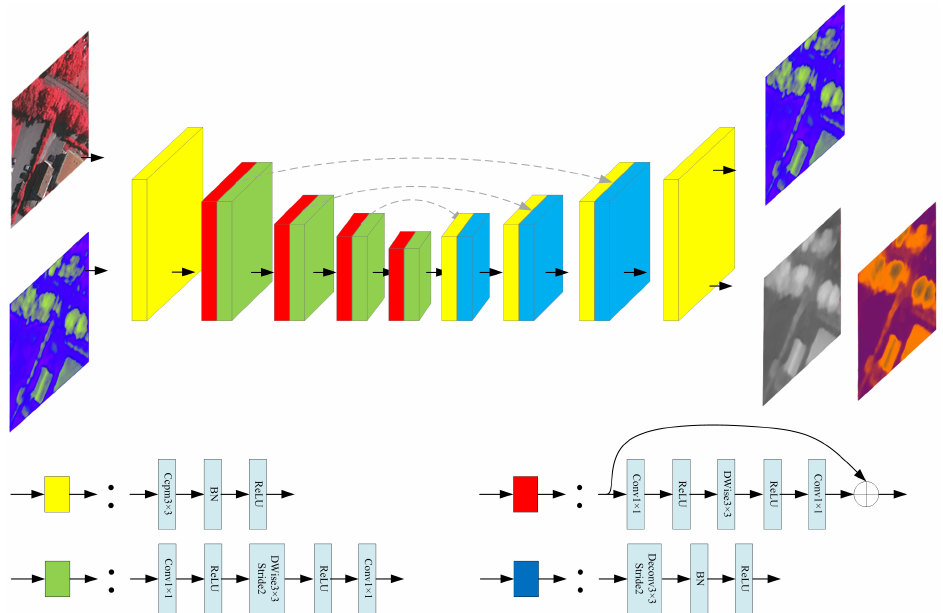
Figure 2. Sub-network architecture. The three sub-networks use the same network structure, but according to different specific tasks, the input and output data are